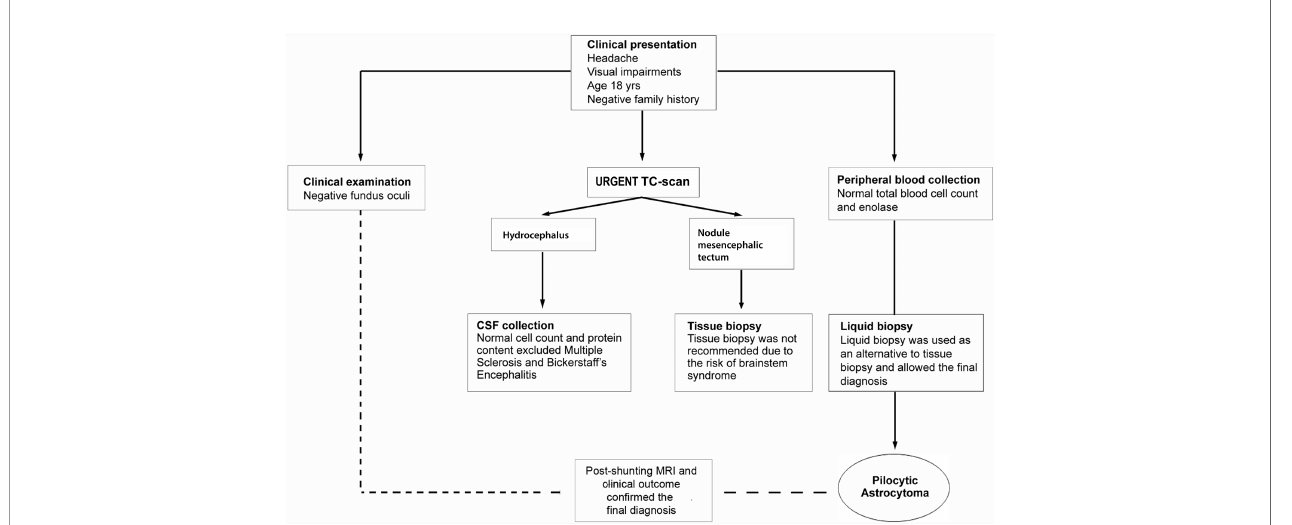
FIGURE 1 | Flow chart of diagnostic work-up. Clinical presentation with headache, visual disturbances, and the intracranial location required differential diagnosis with a wide range of CNS conditions age-related. The patient underwent to clinical examination, instrumental and biochemical analyses. During the hydrocephalus decompression procedure, a sample of CSF fl uid was collected. The CSF was clear and the cell count and protein content were normal. Disorders such as multiple sclerosis and Bickerstaff ’ s encephalitis, conceivable for the clinical symptoms and young age, were excluded. The tissue biopsy needed to exclude high-grade glioma, pineocytoma, germinoma or infectious and parasitic diseases was not recommended. Clinicians opted for performing a protocol of short-time culture on chamber slide to obtain cytological preparations from the blood. Pathological evaluation on liquid biopsy cytological specimens suggested the fi nal diagnosis of pilocytic astrocytoma further con fi rmed by post-shunting MRI and 68 months of clinical